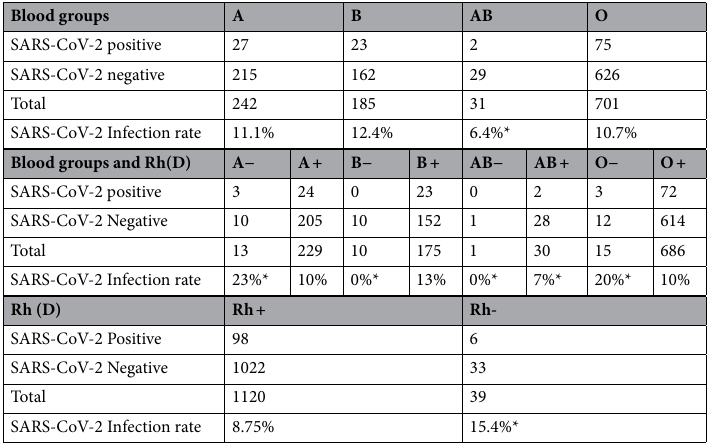
Table 4. Infection rate by blood groups ABO and Rh (D). *A very low number of subjects to draw a meaningful